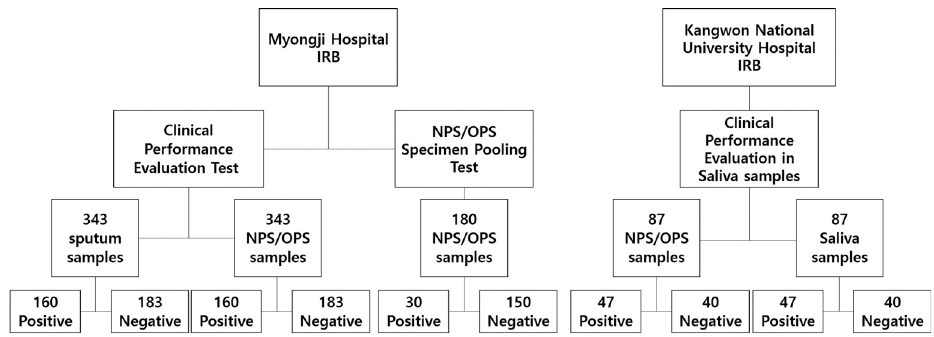
Fig 1. Summary of clinical specimens analyzed in this study. NPS, Nasopharyngeal Swab; OPS, Oropharyngeal Swab.